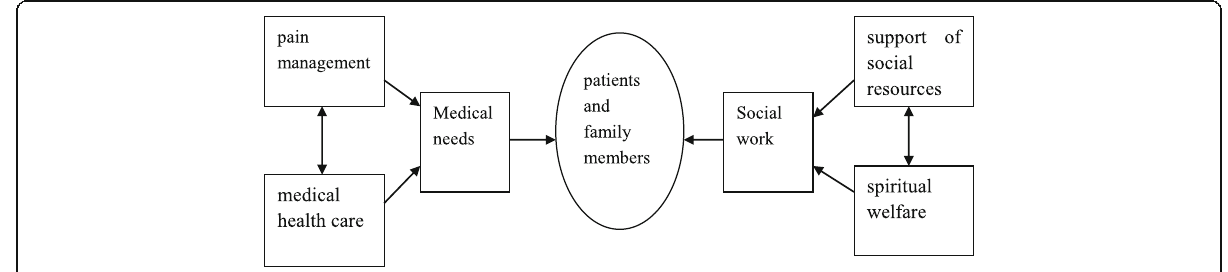
Fig. 1 The figure of social work services intervention in hospice